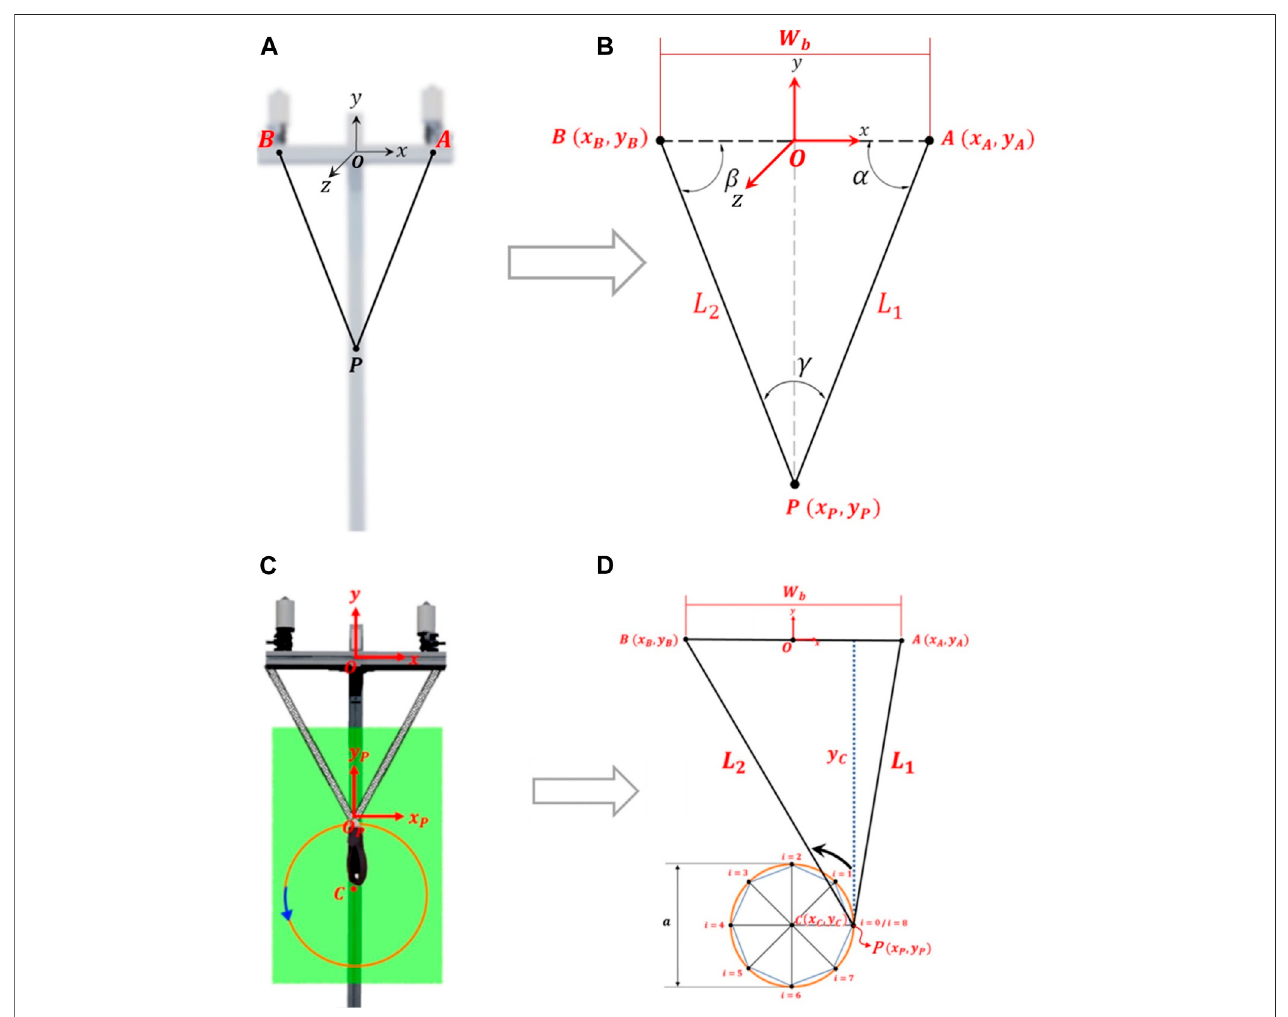
FIGURE 3 | Trajectories: (A) computational model and (B) schematic to obtain the mathematical model for planar trajectory, (C) and (D) for circular trajectory (example with 8 points).